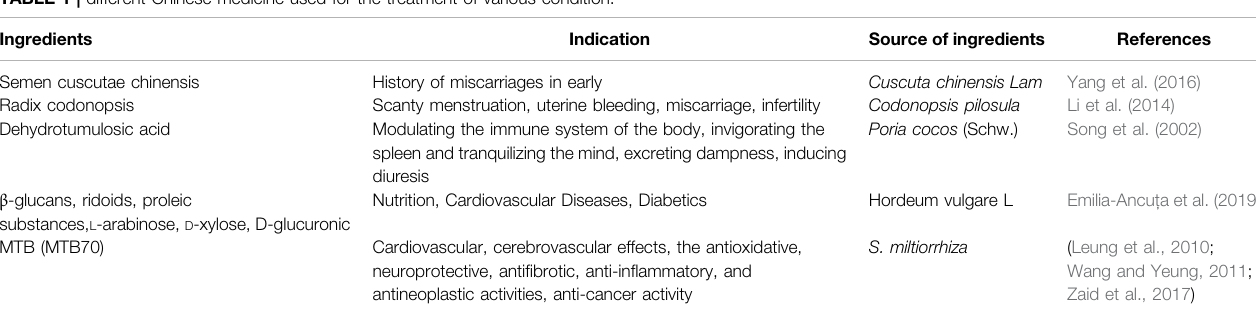
TABLE 1 | different Chinese medicine used for the treatment of various